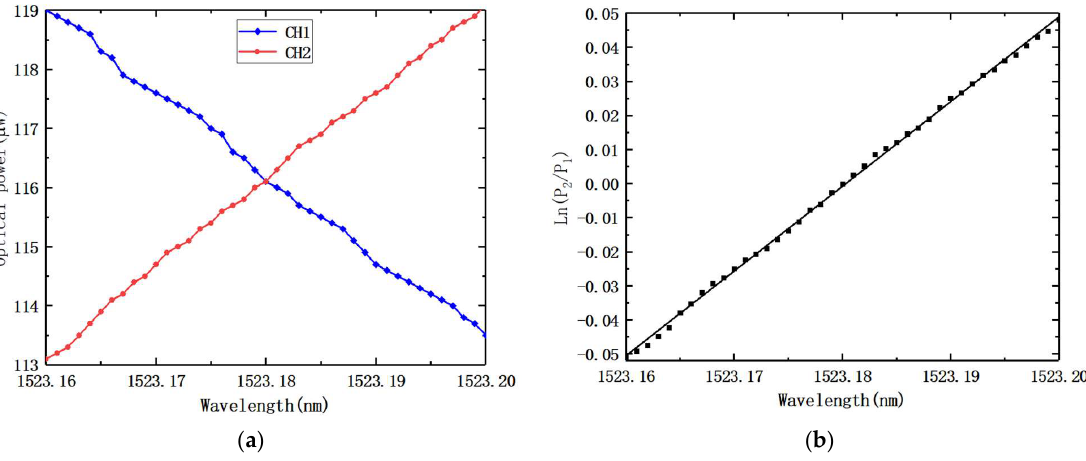
Figure 14. The resolution test of the AWG-based FBG interrogation system: ( a ) the optical power of adjacent AWG channels; ( b ) the logarithm of the output optical power ratio of adjacent AWG channels (channels 1 and 2).